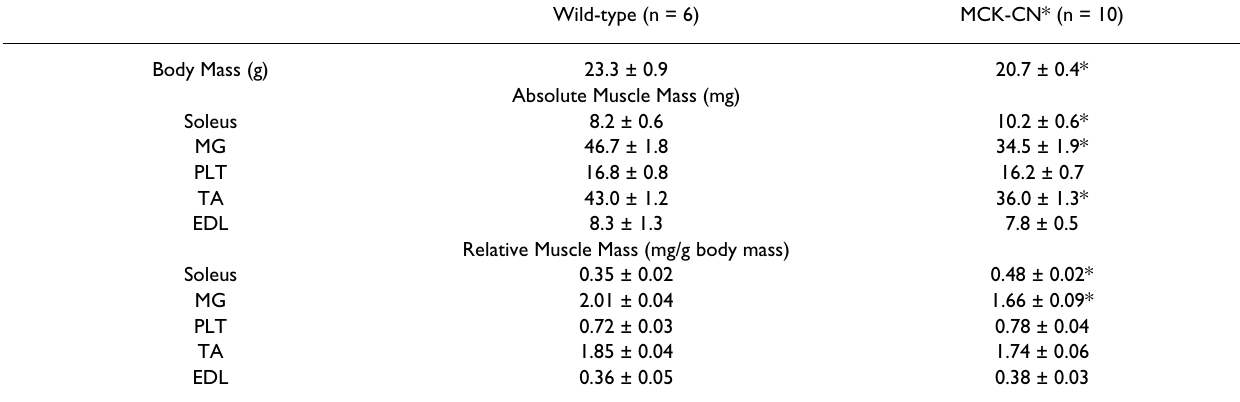
Table 1: Body and absolute and relative muscle